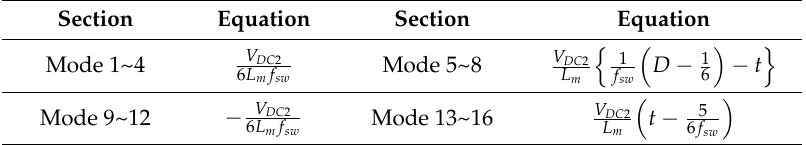
Table 5. Magnetizing inductor current equation of the phase C transformer depending on mode.